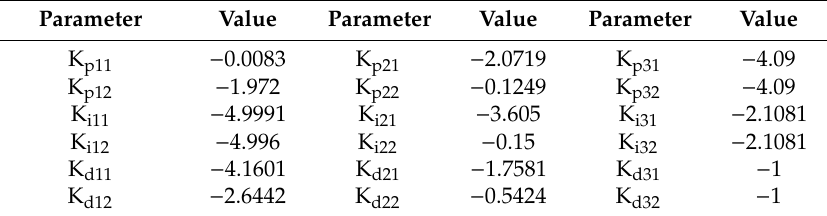
Table 4. Non-optimal control parameter values.